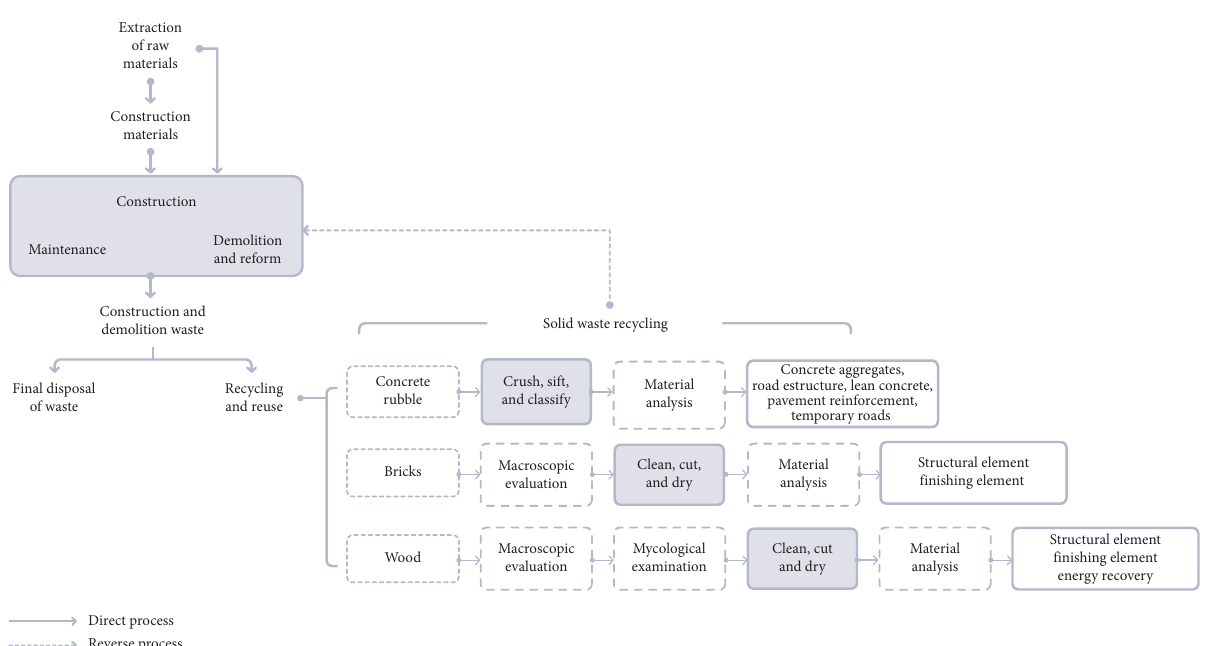
Figure 1: Construction solid